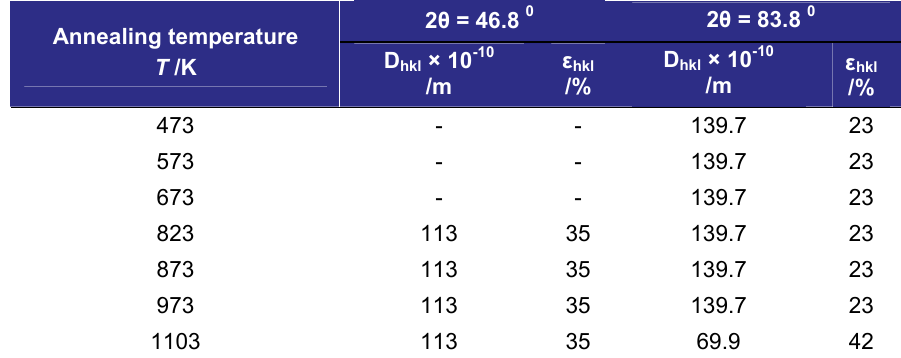
Table 1 – Values of the microstructural parameters of Fe 81 B 13 Si 4 C 2 alloy annealed at different